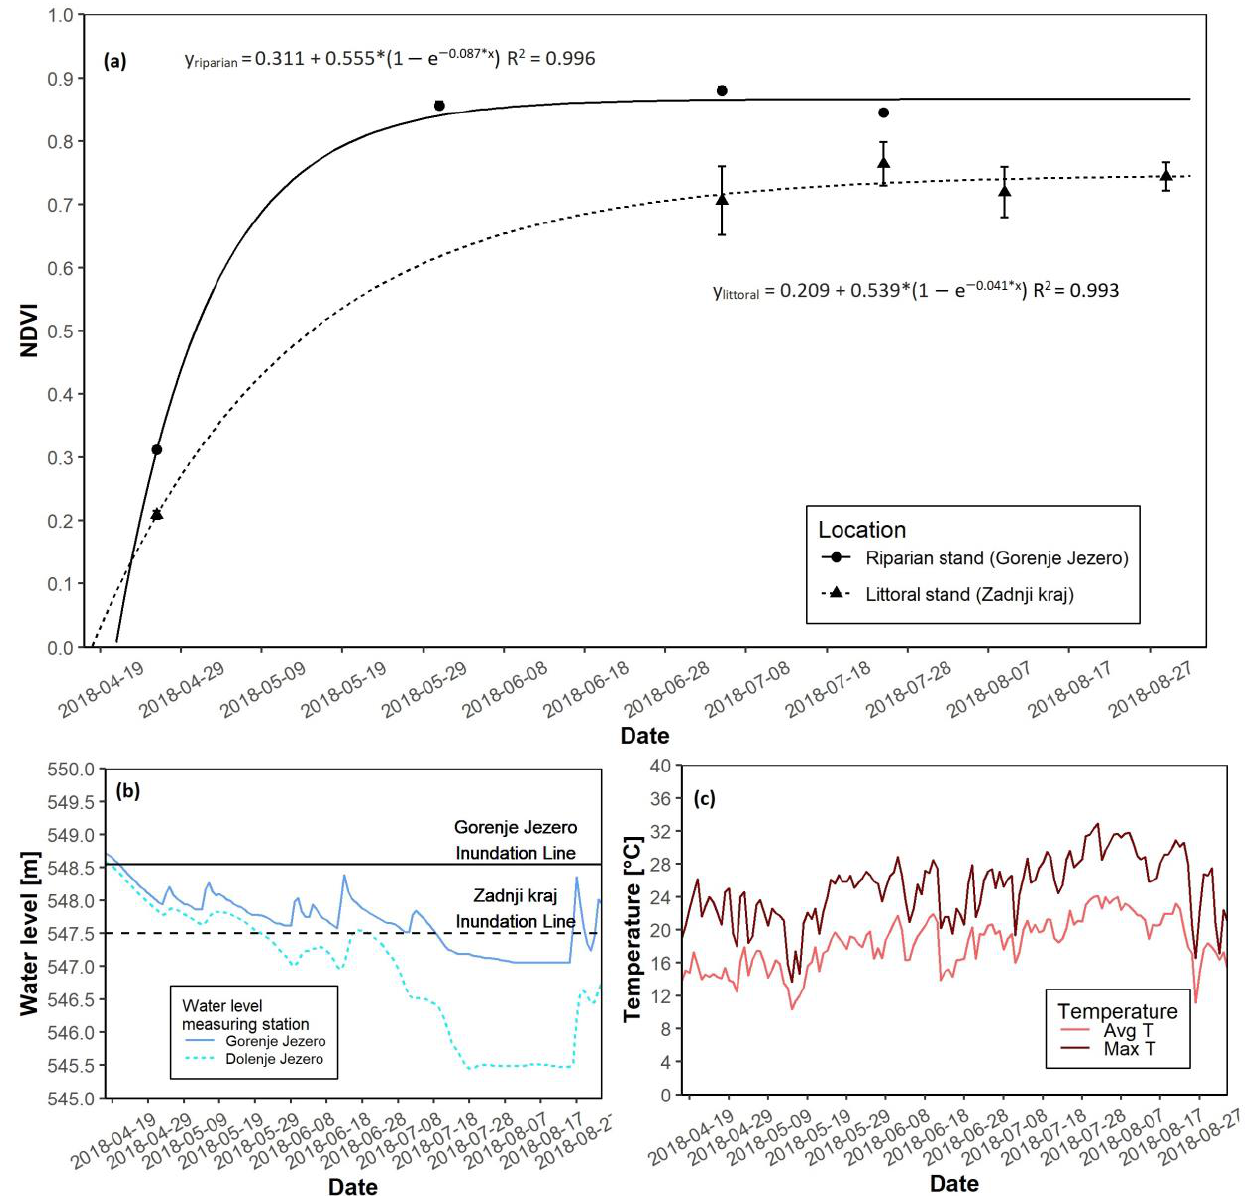
Figure 5. NDVI growth models for both reed sites with water level data for the 2018 growing season. ( a ) NDVI growth models for the riparian and littoral reed stands; ( b ) Water level data for the riparian and littoral reed stands; ( c ) Daily average and maximal temperatures.